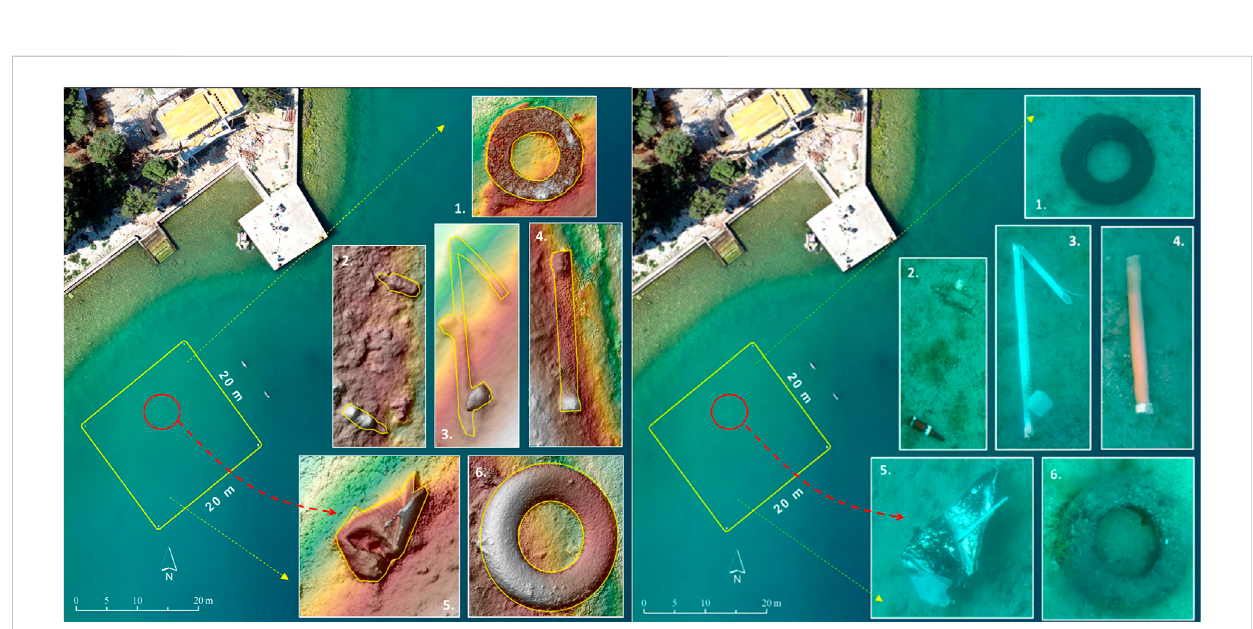
FIGURE 6 Digital surface models (DEMs) and digital orthophotos (DOPs) of the detected marine litter.